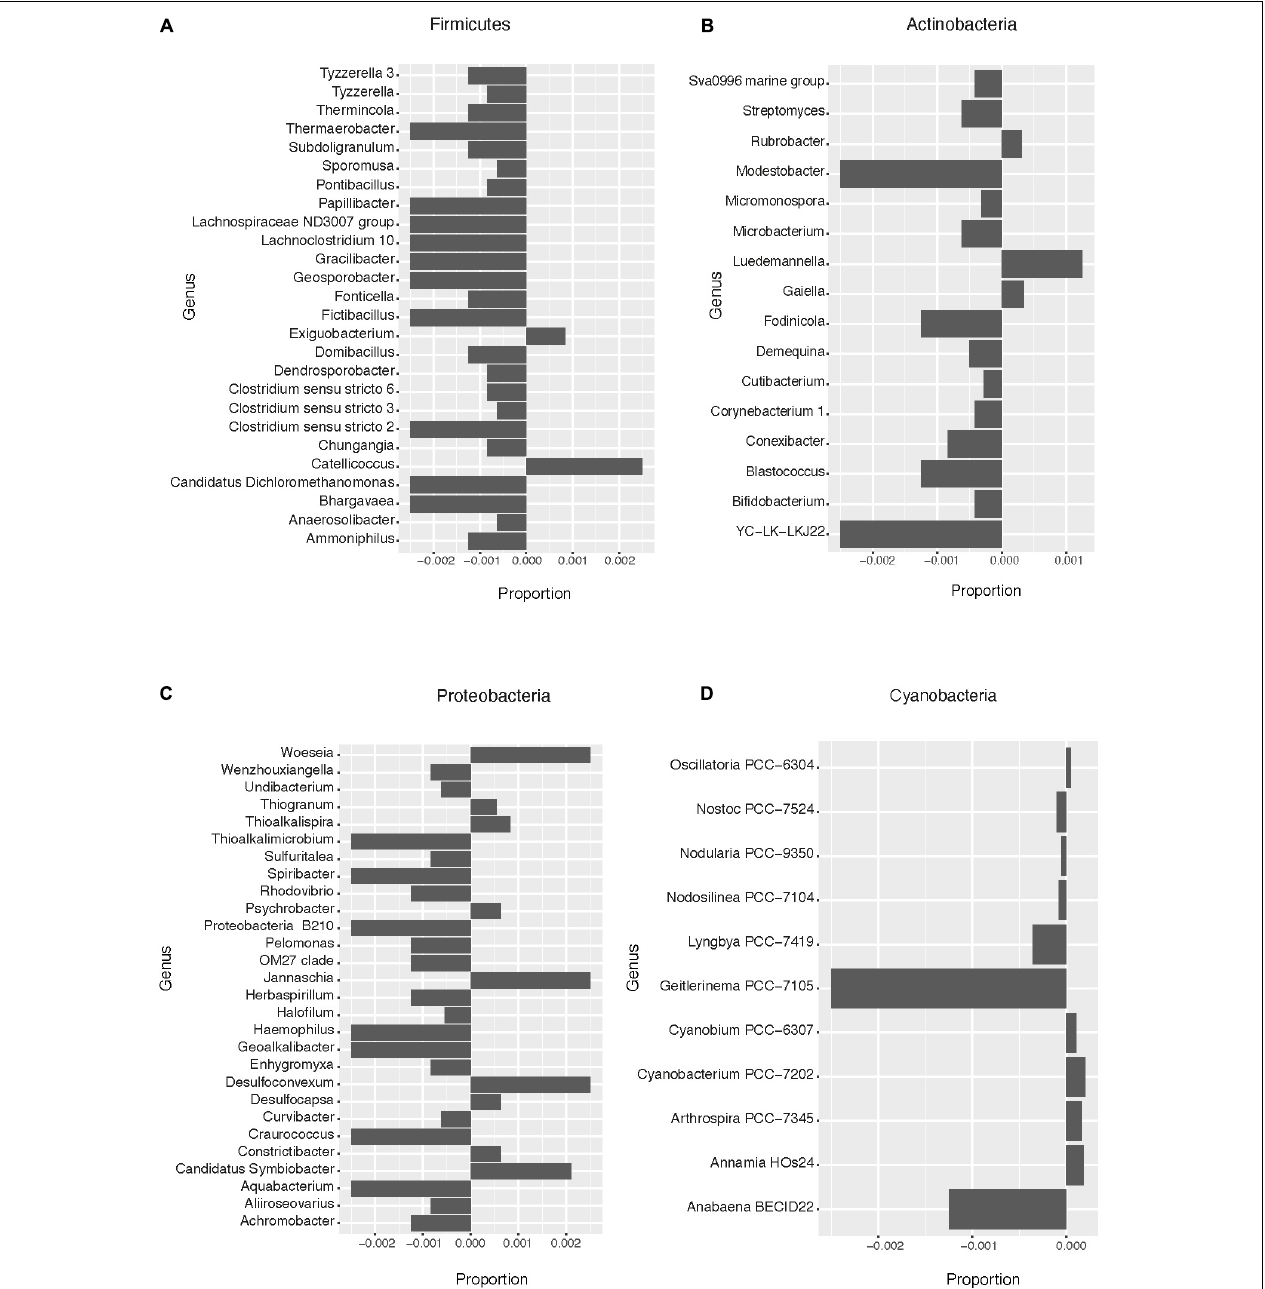
FIGURE 4 | Enrichment of different bacterial genera in the lysis-resistant or total fraction in the lake sediments. Negative values show enrichment in the lysis-resistant fraction, while positive values show enrichment in the total fraction for each genus. (A) Firmicutes genus. Proportion threshold at ≤ 0.0005 and > 0.0005. (B) Actinobacteria. Proportion threshold at ≤ 0.00025 and > 0.00025. (C) Proteobacteria. Proportion threshold at ≤ 0.0005 and > 0.0005. (D) Cyanobacteria. Full